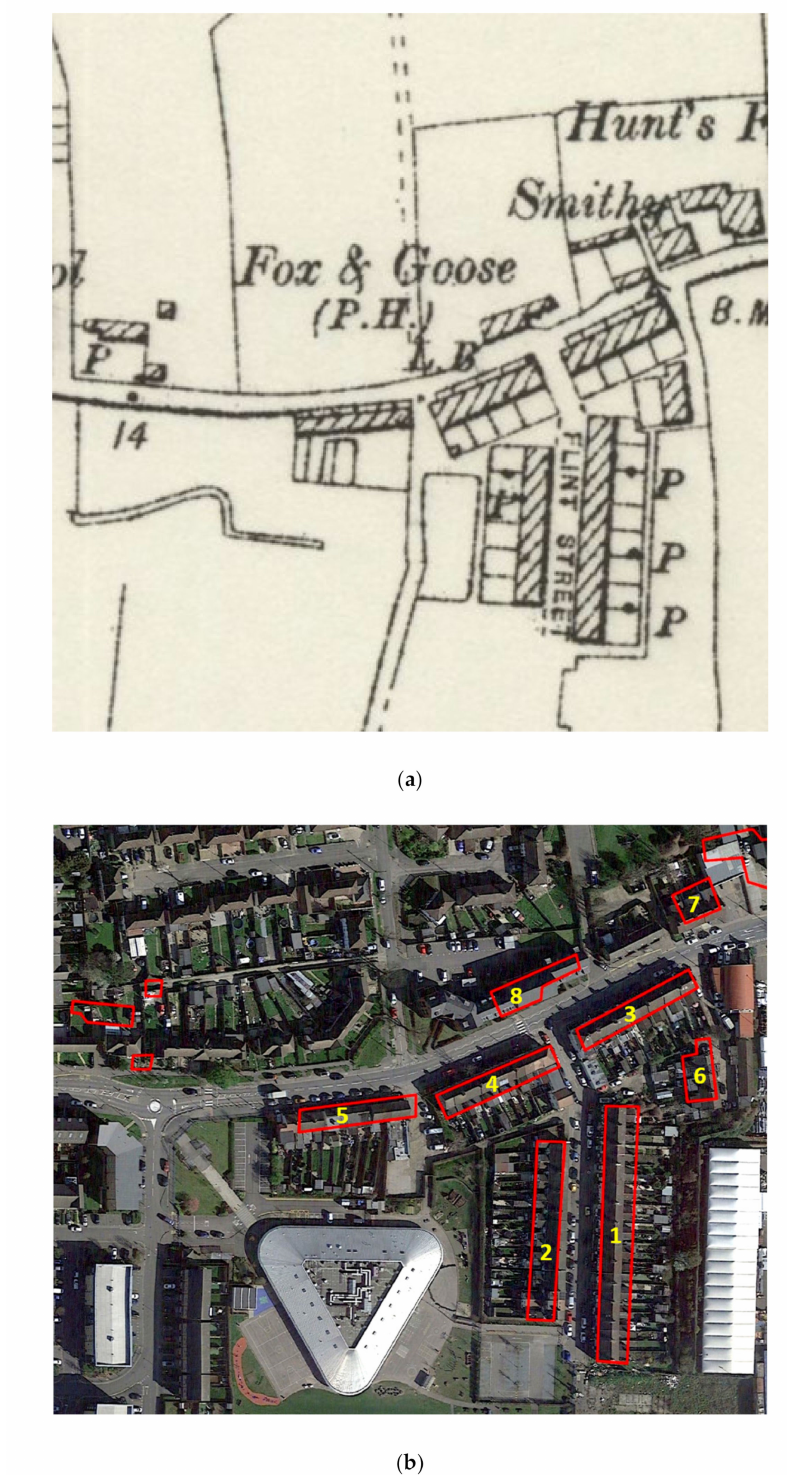
Figure 12. Identified hatched residential areas used for land change monitoring. ( a ) Historic raster map in 1898; ( b ) vector polygons of the extracted hatched residential areas overlap the satellite image from Google